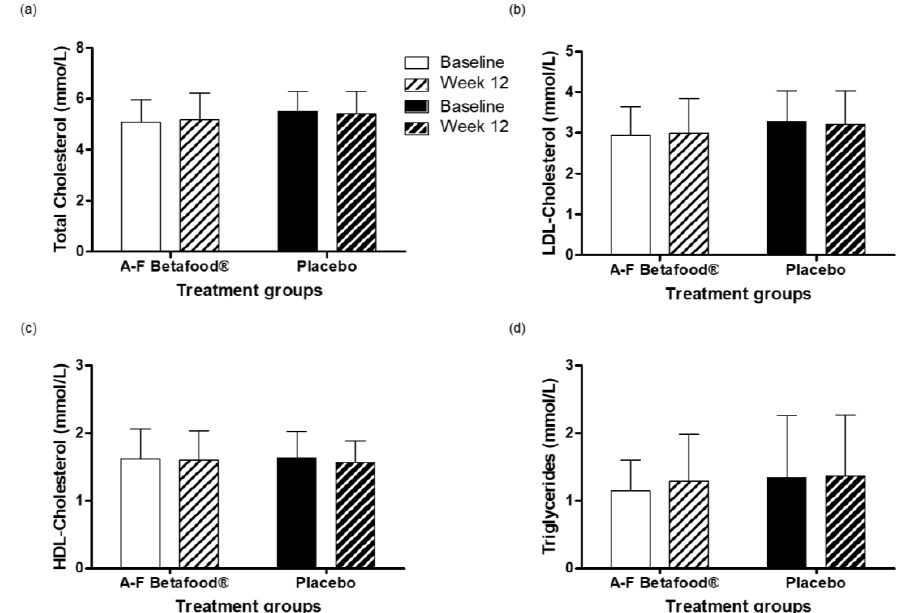
Figure 7. Lipid profile in per protocol population at baseline and week 12 post-supplementation with A-F Betafood ® or placebo ( n = 42). ( a ) Total Cholesterol, ( b ) LDL-Cholesterol ( c ) HDL-Cholesterol and ( d ) triglycerides levels. Mean ± SD. LDL, low-density lipoprotein; HDL, high-density lipoprotein.